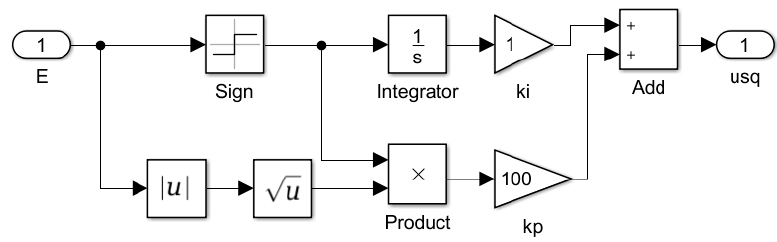
Figure 11. Simulation model of the torque regulator.